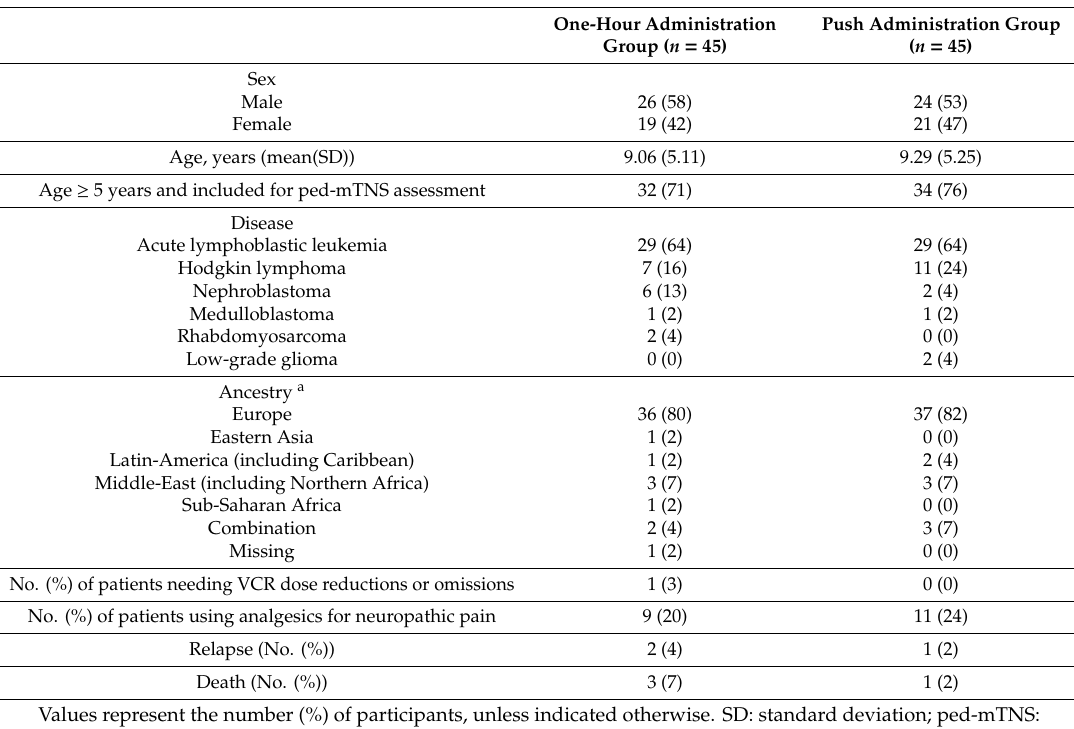
Table 1. Demographic and clinical characteristics of the participants at baseline.